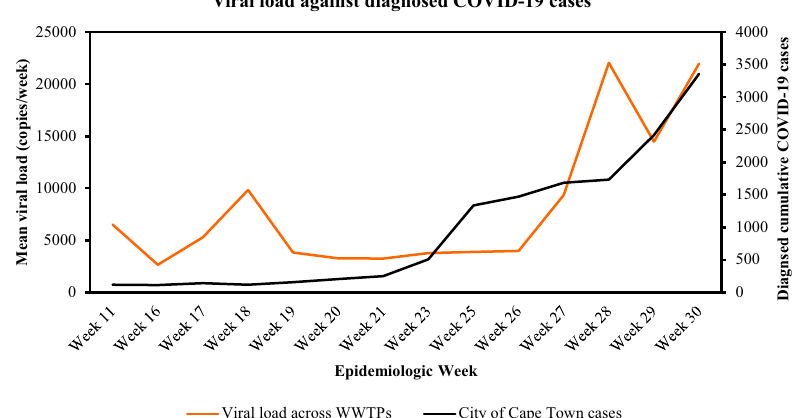
Figure 1. Temporal analysis of SARS-Cov-2 viral load in wastewater against diagnosed COVID-19 cases in Western Cape.